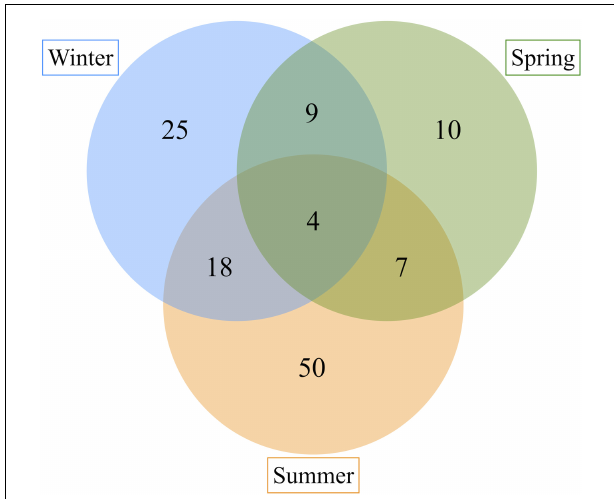
FIGURE 5 | ASVs sharing among C. viridis bacterial communities across seasons. Venn diagram showing the number of ASVs shared between the C. viridis bacterial communities in different seasons. Four ASVs are shared among all the three seasons, nine ASVs between winter and spring samples, 18 between winter and summer samples and seven between spring and summer samples.